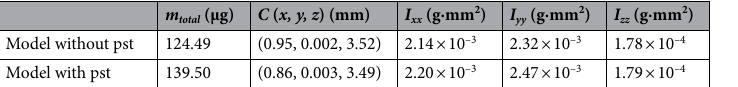
m total (μg) C ( x, y, z )